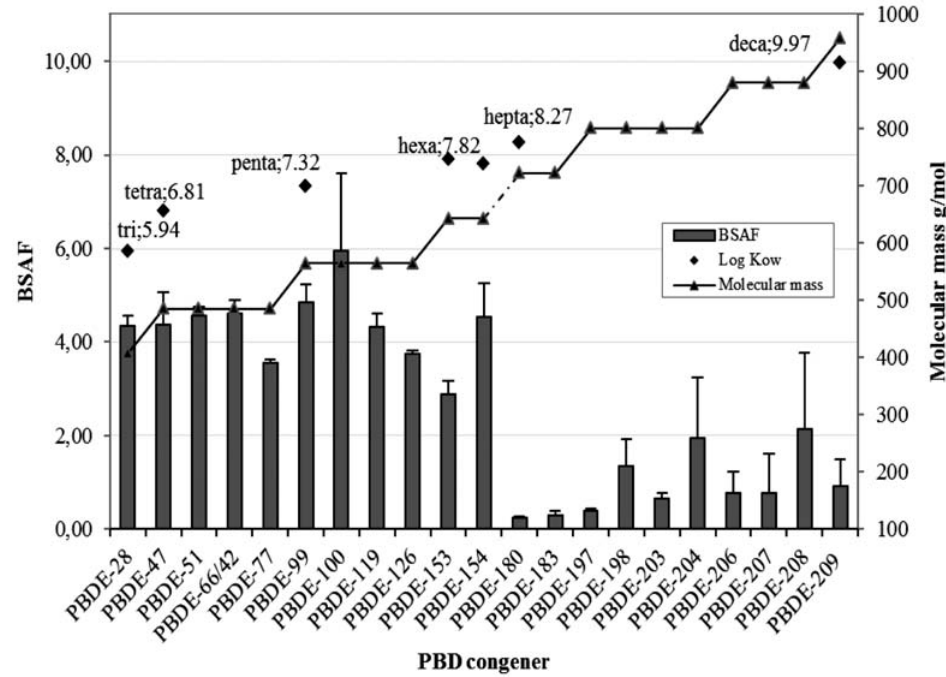
Figure 2. The biota-sediment assessment factor (BSAF) of tri- to deca-homologues of the BDEs in relation to the molecular mass and the measu- red log K . The dotted line indicates the bioaccumulation gap between the hexa- and OW